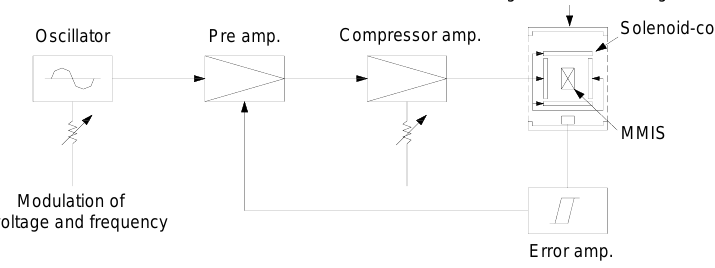
Figure 9. Experimental apparatus for static characterization of fabricated